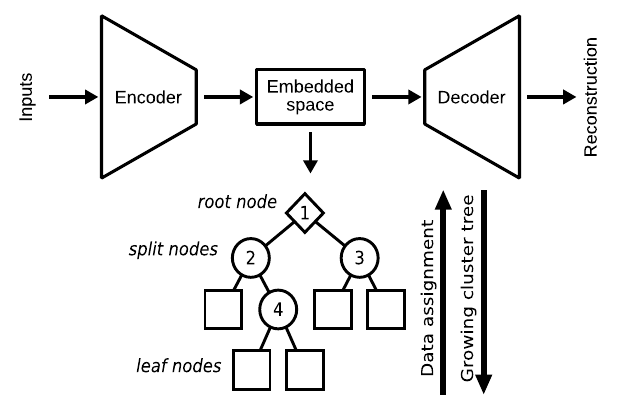
Fig. 1 The figure shows an illustration of the combined architec- ture of the DeepECT clustering algorithm and an autoencoder. The autoencoder network transforms the input data into an embedded space, where DeepECT is used to cluster it. The numbers in the illus- trated cluster tree indicate the split